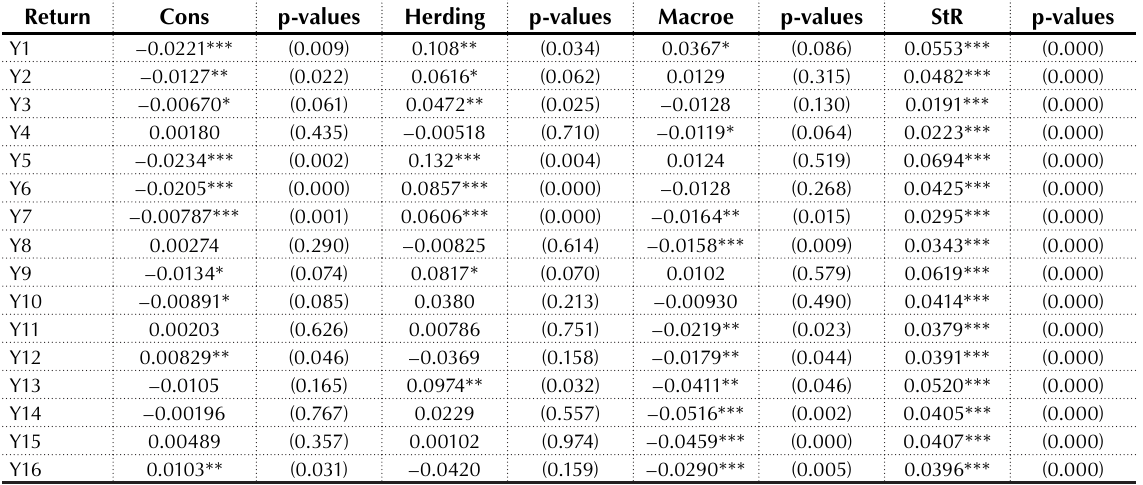
Table 5. The impact of herding and macroeconomic indicator on returns of contrarian